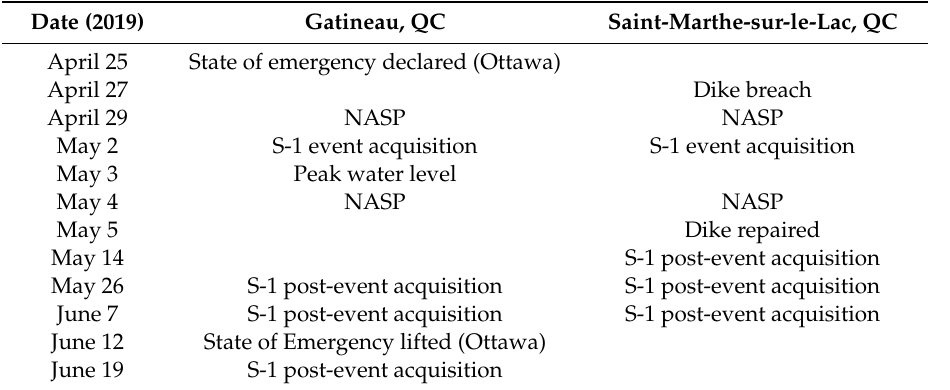
Table 3. S-1 image dates for urban flood mapping using Coherent Change Detection (CCD), with significant flood events in Gatineau and Sainte-Marthe-sur-le-Lac, QC.